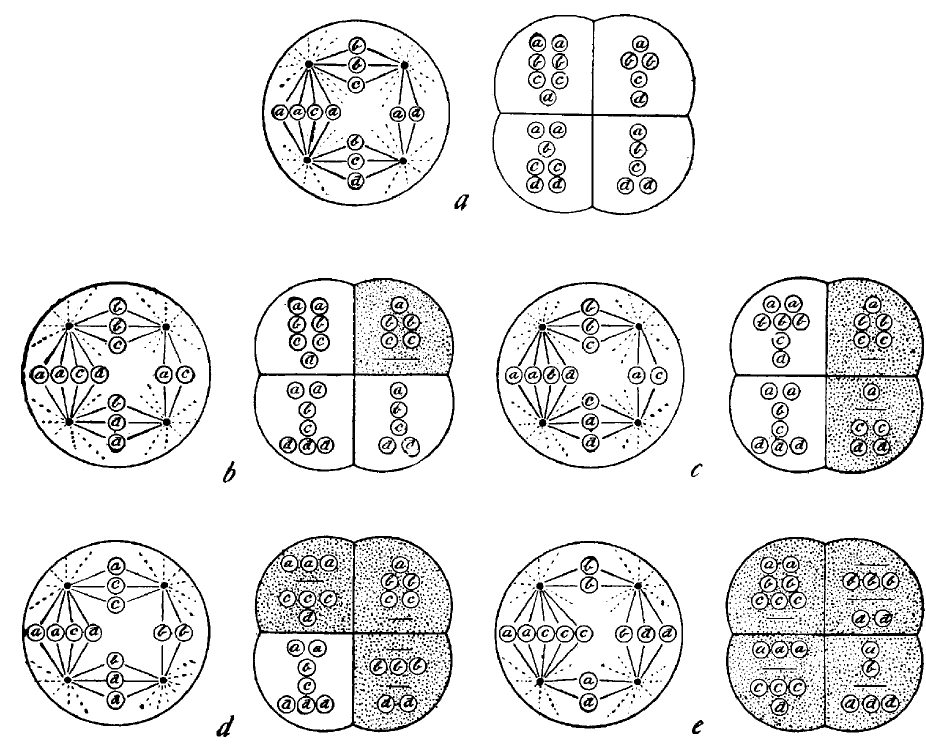
Figure 2 - Boveri’s model of multipolar division in dispermic eggs. Irregular chromosome distribution can produce cells with com- pletely different sets of chromosomes (at least one of each kind) or cells with an incomplete chromosome set (gray cells, in the